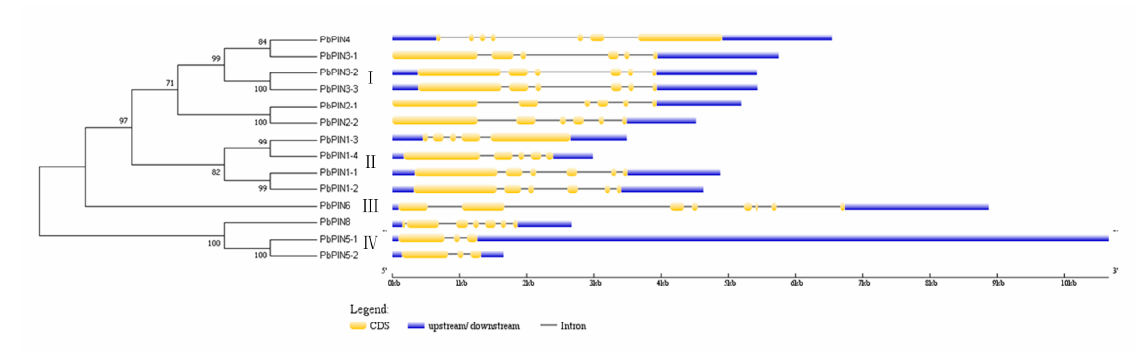
Figure 2. Phylogenetic relationship and exon-intron structure of PbPINs in Pyrus . The neighbor-joining tree was constructed using MEGA 7.0. Bootstrap values are indicated on the nodes of branches. The yellow boxes denote CDS (Coding Sequence), the blue lines show UTR (Untranslated Regions), and the black lines represent intron.